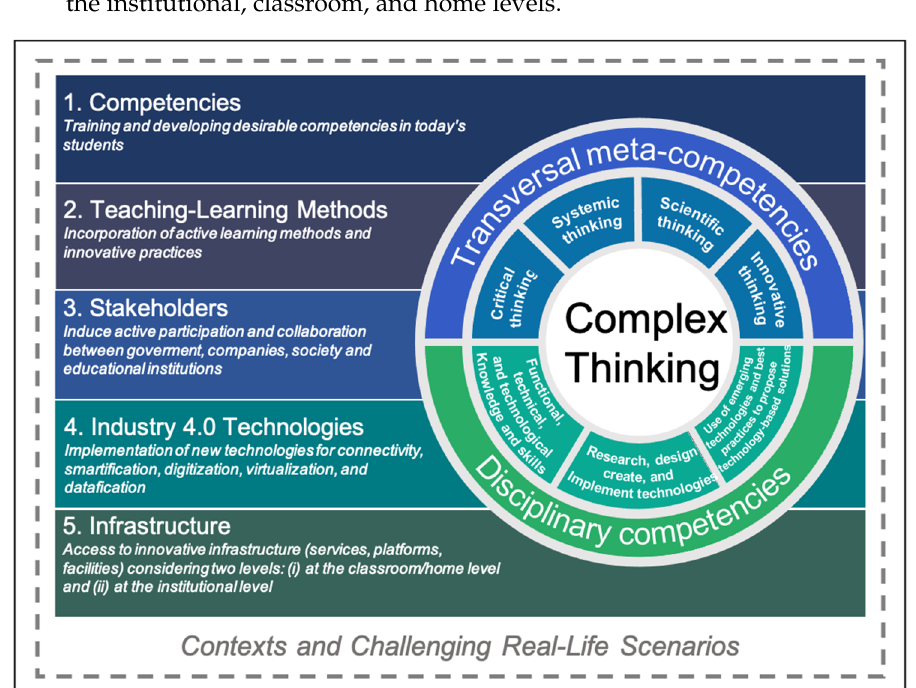
Figure 1. Complex thinking in Education 4.0.